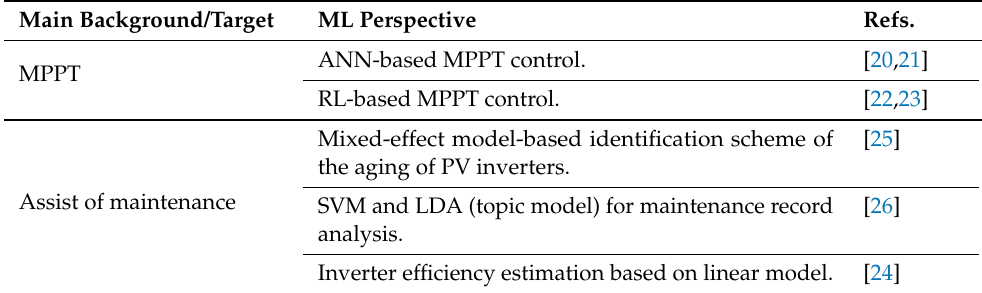
Table 2. Relevant studies on ML-based individual DER system